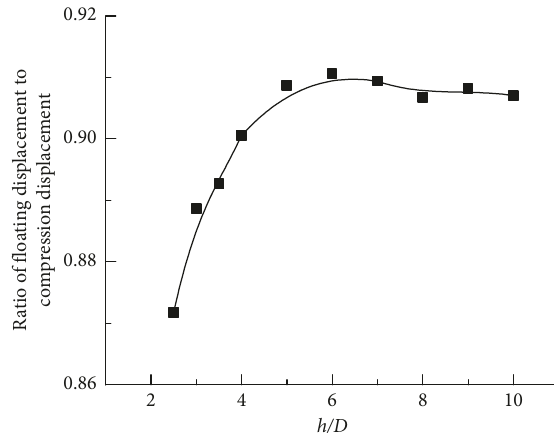
Figure 14: Variation of the ratio between soil compression dis- placement and segment floating